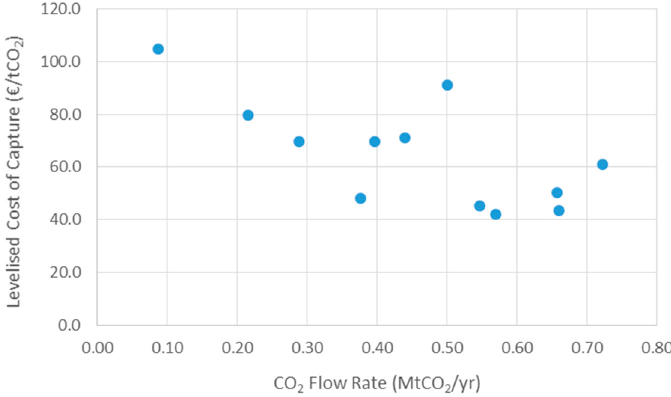
Figure 2. Levelized cost of capture (in €/tCO 2 ) for the cement industry (using data from [50,59–62]).